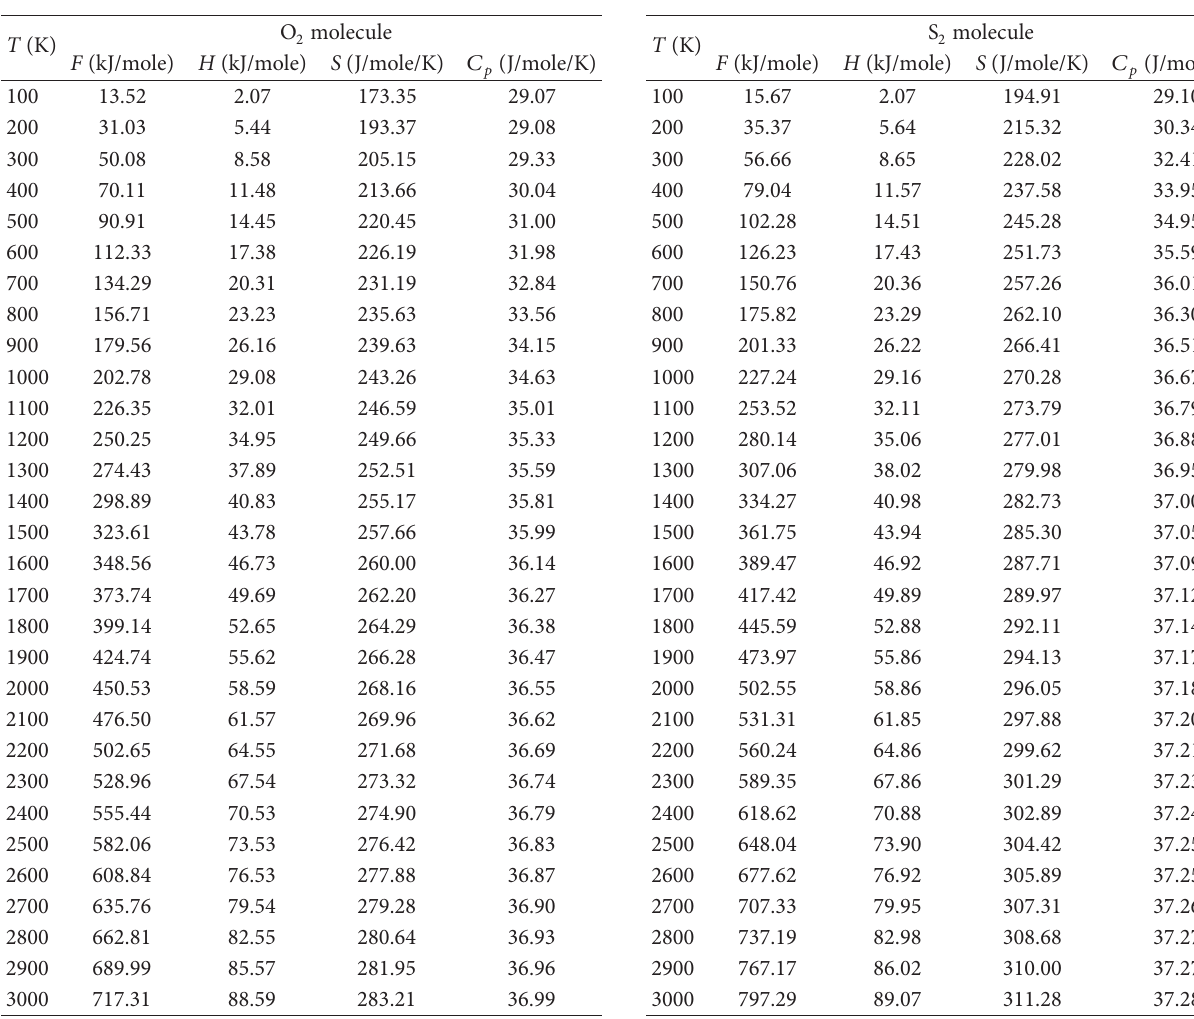
T 1: Calculated thermodynamical properties of